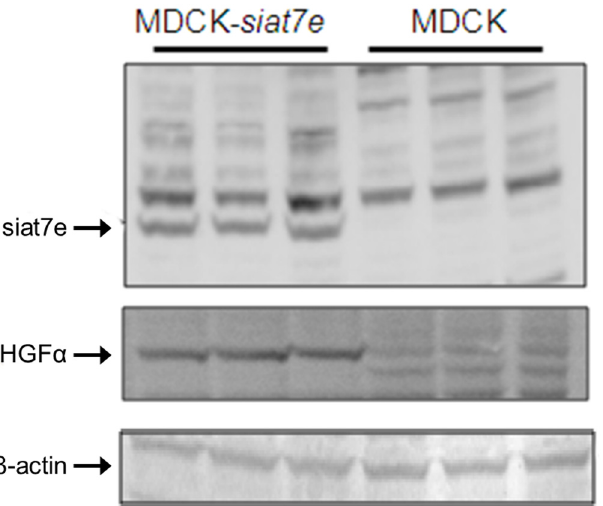
Fig 2. Immunoblot analysis of whole cell lysates of parental MDCK and MDCK siate7e cells, detecting expression of SIAT7E protein, hepatocyte growth factor alpha (HGF α ) and Beta-actin expression as loading control. Three biological replicates are shown for both MDCK- siat7e and parental MDCK cells.